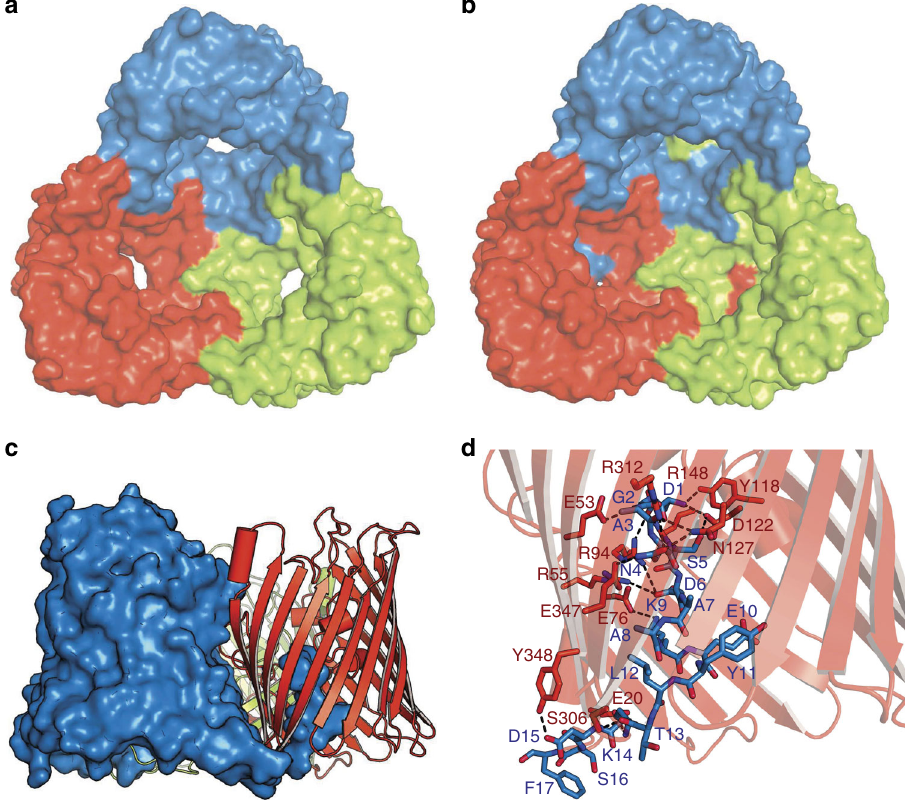
Fig. 2 OM-expressed Vh Chip has N-terminally plugged channels. a , b Surface representations (top view) of in vitro-folded Vh ChiP ( a ) and natively expressed Vh ChiP ( b ). The barrel lumen of the natively expressed Vh ChiP is occupied by the N-terminus of a neighbor barrel. c N-terminal insertion mode of natively expressed Vh ChiP. The N-terminus of one barrel (blue) plugs the lumen of a neighbor barrel (red). d Polar interactions between the inner barrel wall (red) with the N-terminus of a neighbor barrel